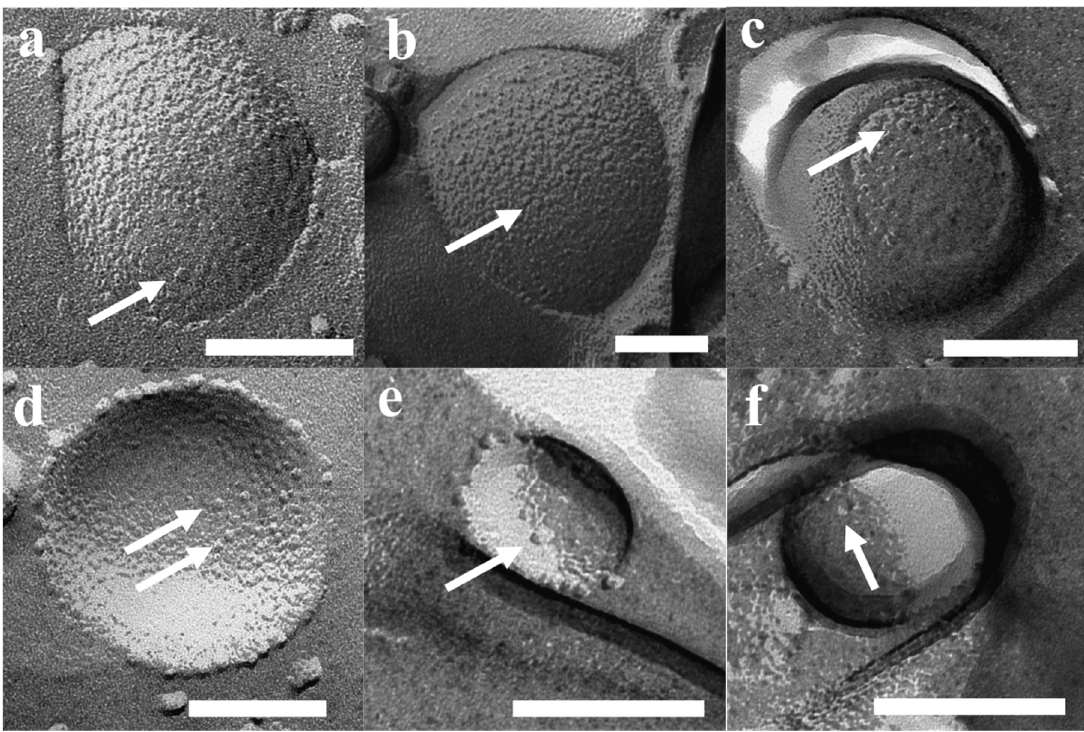
Figure 5. FF-TEM images of PB 45 -PEO 14 proteo—( b , c , e , f ) and polymersomes ( a , d ).